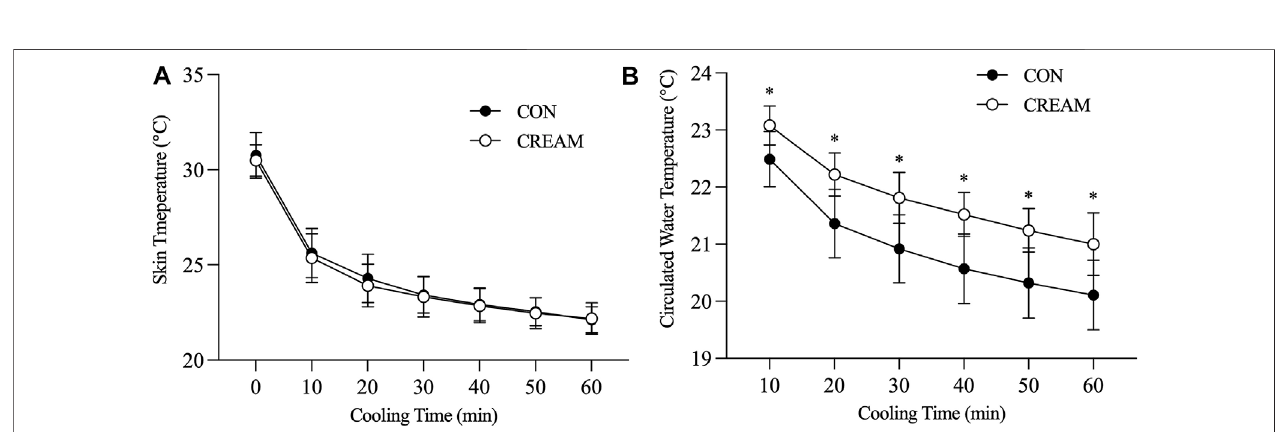
FIGURE 3 | Skin temperature (T sk ) and circulated water temperature during local skin cooling. T sk (A) and circulated water temperature (B) during Baseline (0) and 60-min local cooling are shown. CON, control cooling; CREAM, cooling with cutaneous application of analgesic cream. Two-way repeated measures ANOVA with a Tukey ’ s post-hoc test for all. Data are presented as the mean ± SD ( n = 10). * p < 0.05 vs. CON.